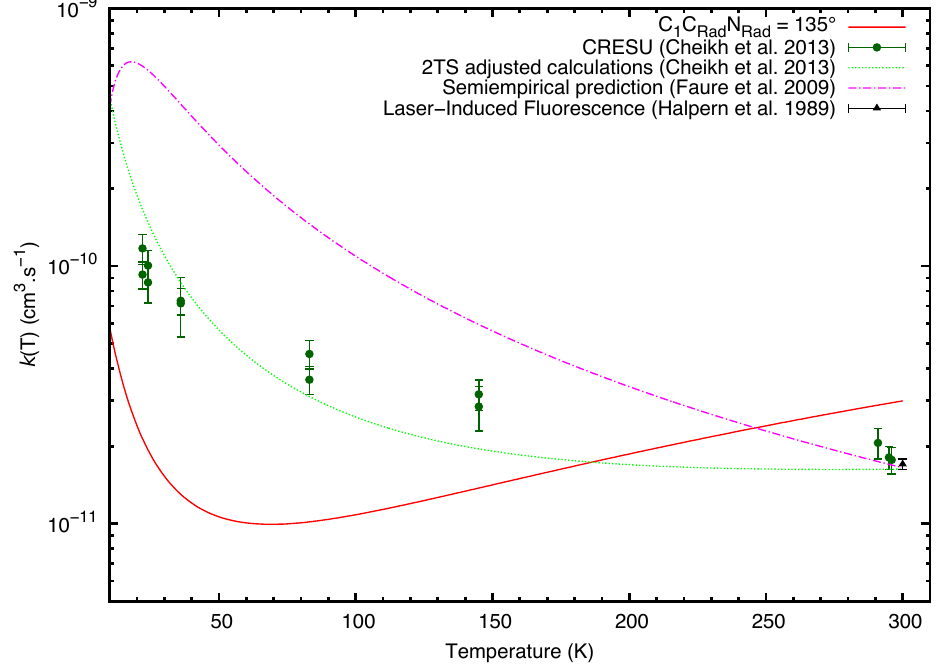
Figure 5. Rate coefficients for the reaction between cyanoacetylene and cyano radical (in cm 3 s − 1 ) in function of the temperature (in K). In full-line red, data from this work at The room temperature rate coefficient evaluated in the work by Halpern et al. [31] is represented by a black triangle with error bars. The dashed-dotted magenta line, represents the semiempirical prediction by Faure et al. [32]. The dark-green circles with error bars represent the experimental rate coefficients and the green dotted line represents the theoretical rate coefficients, both extracted from the publication by Cheikh Sid Ely et al.